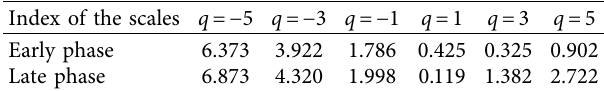
Figure 16: Multifractal